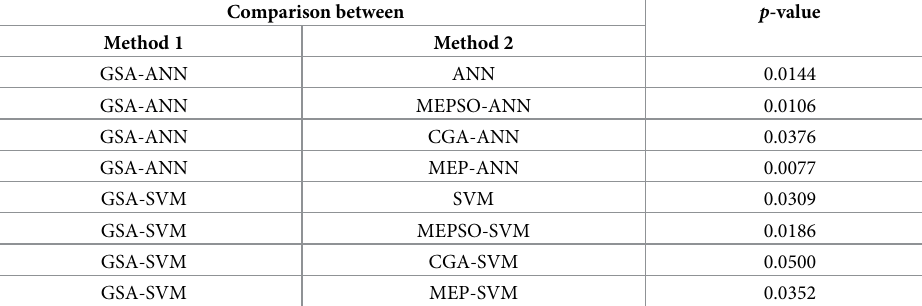
Table 11. Statistical test of non-parametric using McNemar’s test for the method proposed. Comparison between p